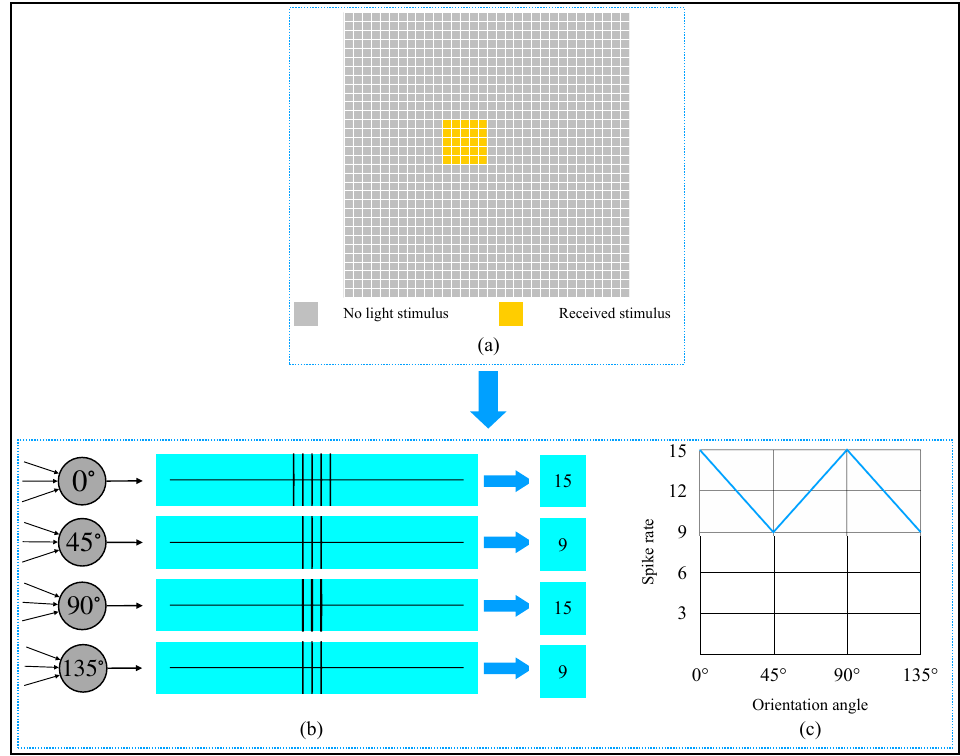
Figure 14. Computer simulation results of orientation angle detection on a square. ( a ) Object. ( b ) Spike records. ( c ) Spike rate curve of four types of complex